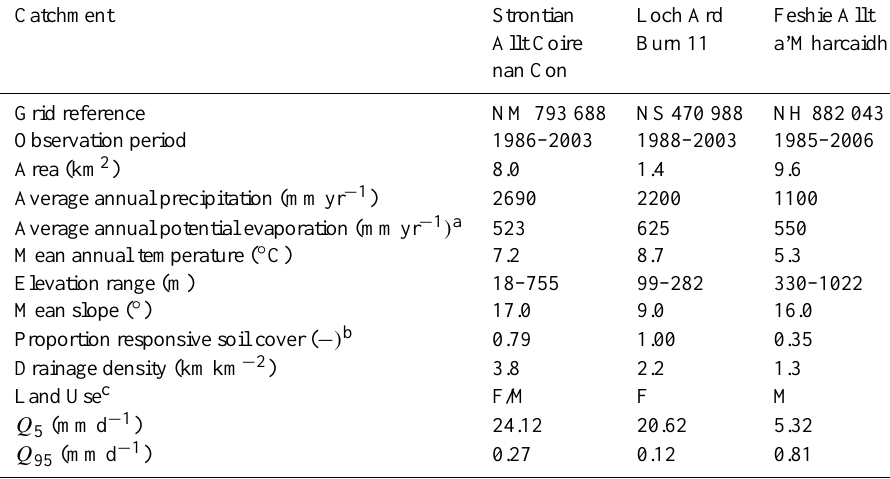
Table 1. Characteristics of the three study